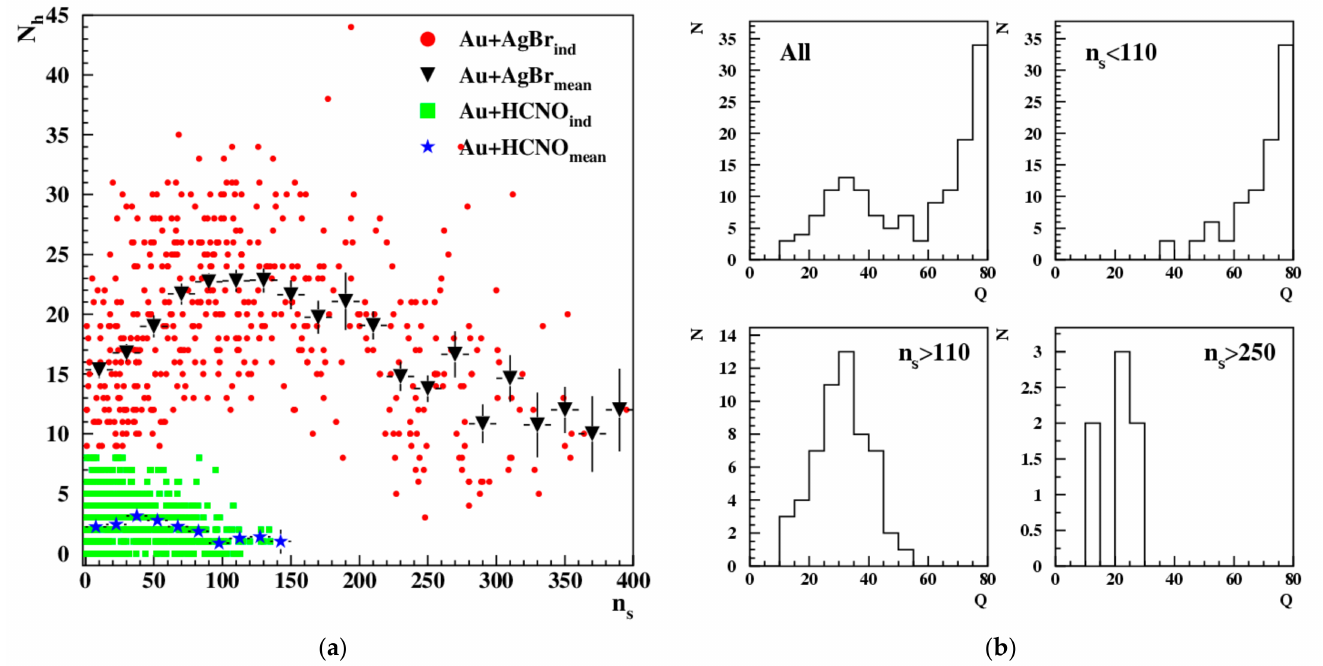
Figure 2. ( a ) Dependence between the number of target-nucleus fragments and the number of shower particles in the interactions of Au-197 with heavy (AgBr) and light (HCNO) emulsion nuclei at 10.6 AGeV. ( b ) Charge distribution of a multi-charged fragment of projectile-nucleus for the interaction of Au + AgBr with one multi-charged fragment N f = 1 depending on the n s